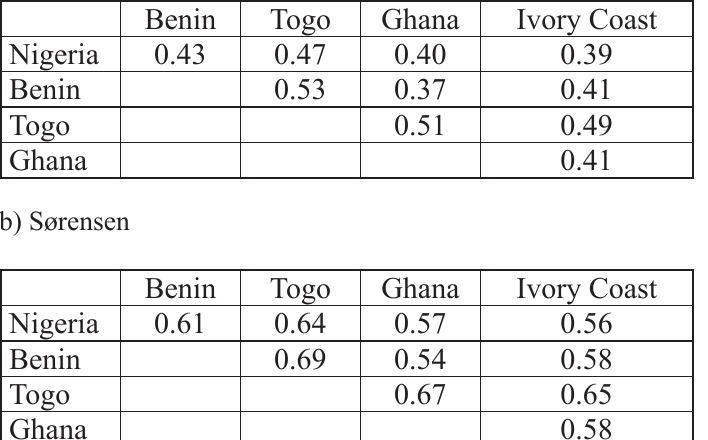
Table 5. Incidence based similarity indices (a: Jaccard; b: Sørensen) for Tephritidae between the countries in the study area. range 0-1, with 0 being no similarity and 1 being complete